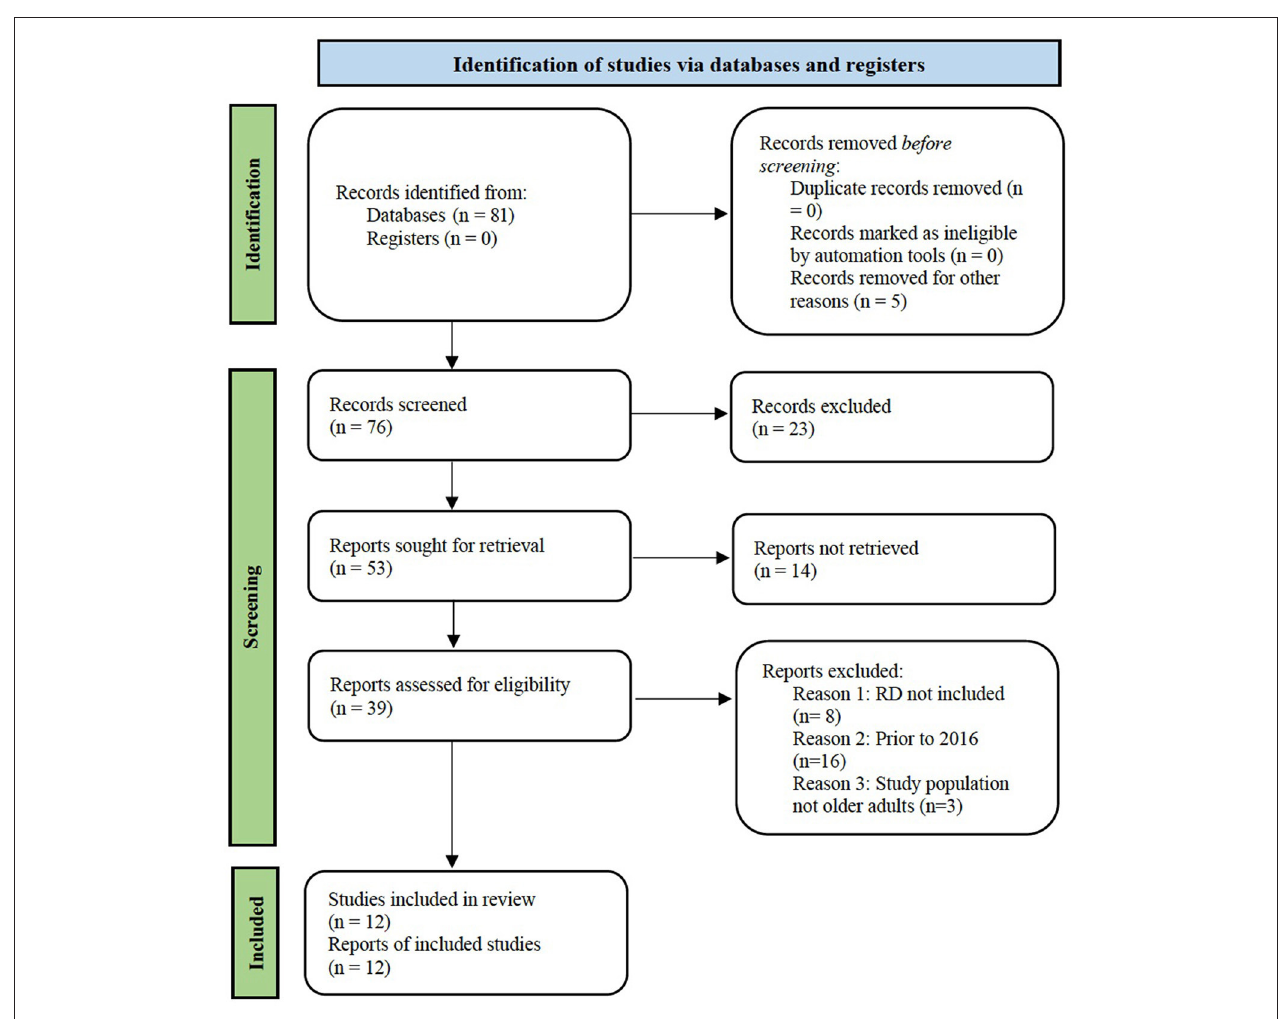
FIGURE 1 | Flowchart of article identification, screening, and selection process for systematic